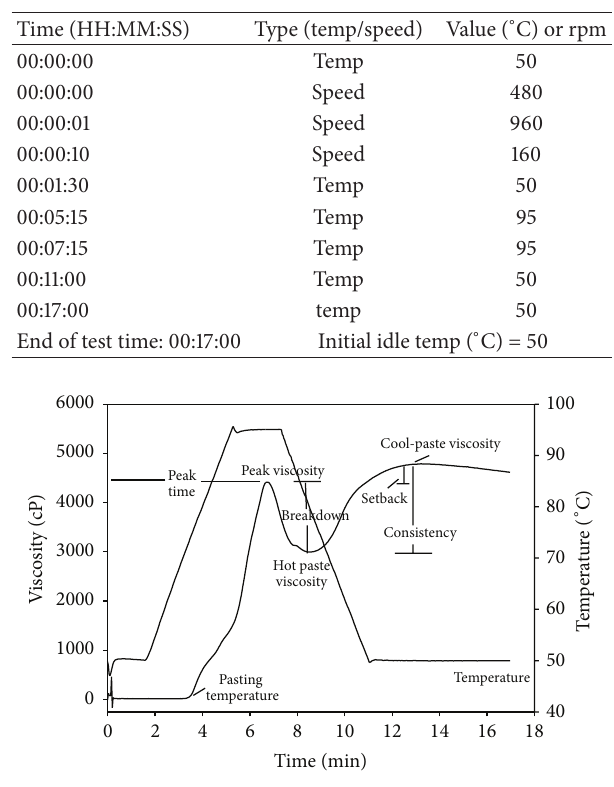
Table 1: Detail of RVA analysis cycle of rice.